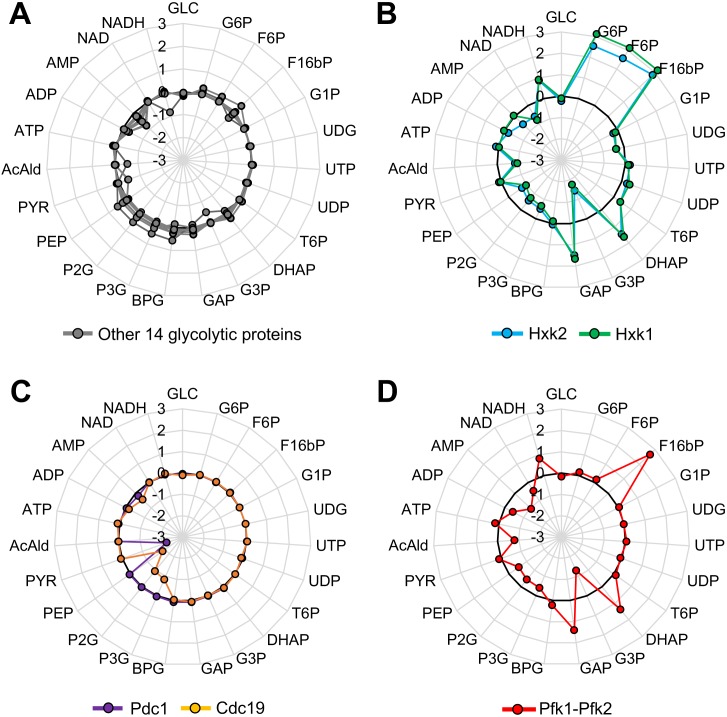
Metabolic perturbations triggered by overexpression of glycolytic proteins in silico.(A–D) Metabolic change triggered by overexpression of the indicated glycolytic protein in a kinetic model of glycolytic metabolism (Smallbone et al., 2013). Log10 fold-change in each metabolite level in a simulation with 128-fold overexpression of each glycolytic protein compared to that in the wild-type is shown. In (D), Pfk1 and Pfk2 are simultaneously overexpressed.10.7554/eLife.34595.015Figure 4—source data 1.This spreadsheet contains all data and statistical values associated with the figure.